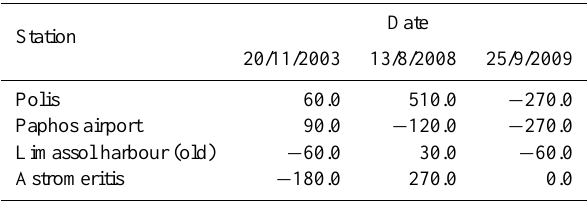
Table 5. Water losses (tonnes per month) for 1 hectare (Mandria